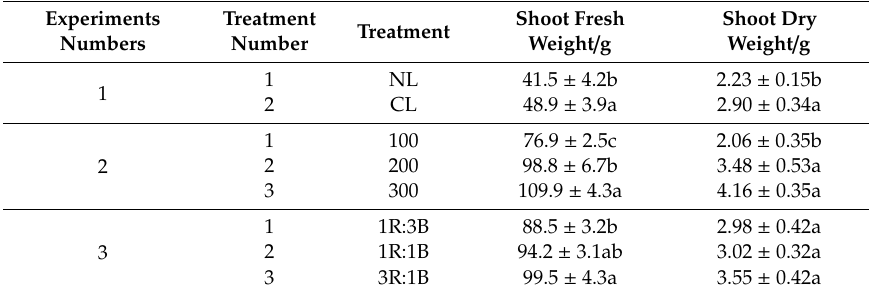
Table 2. E ff ects of light intensity and quality of continuous lighting emitted by red / blue LEDs on shoot biomass of